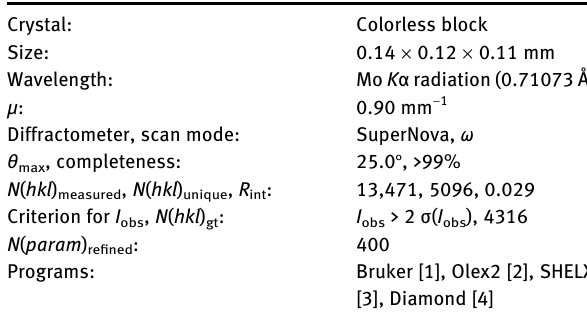
Table  : Data collection and